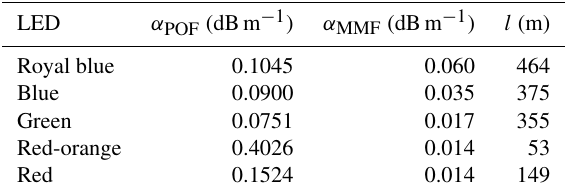
Table 1. Maximum lengths for which the POF benefits over silica fibers. Attenuation data POF: Toray PFU-CD1001-22E ( α POF ); at- tenuation data MMF: Thorlabs FG200LEA ( α MMF ).